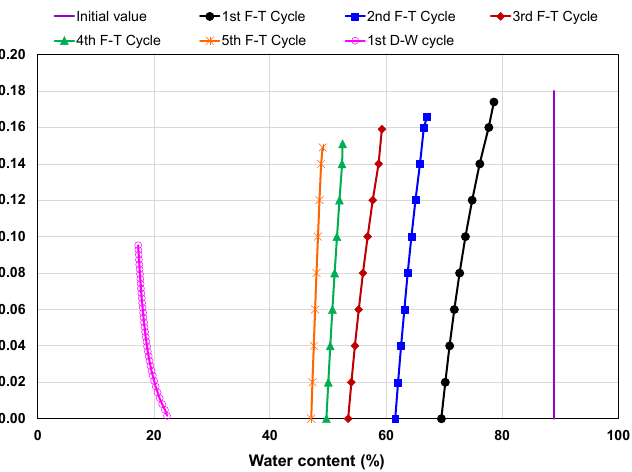
Figure 6. Water content profile simulation of centrifuged tailings at a temperature gradient of 0.028 °C/mm.